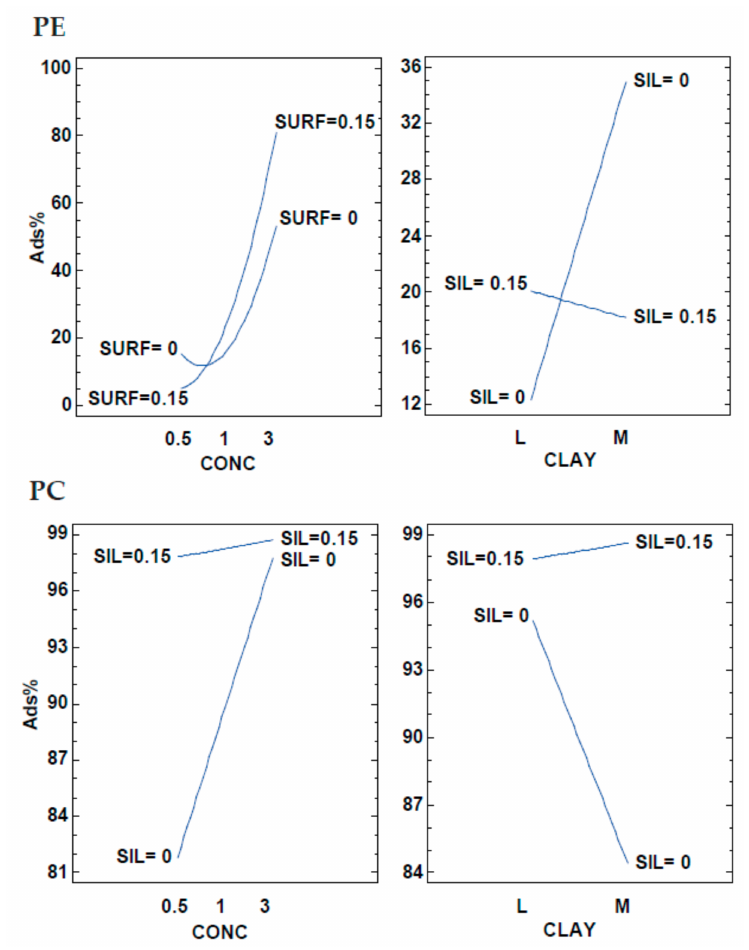
Figure 4. Interactions plot of the PE and PC Ads (%) responses under DOE